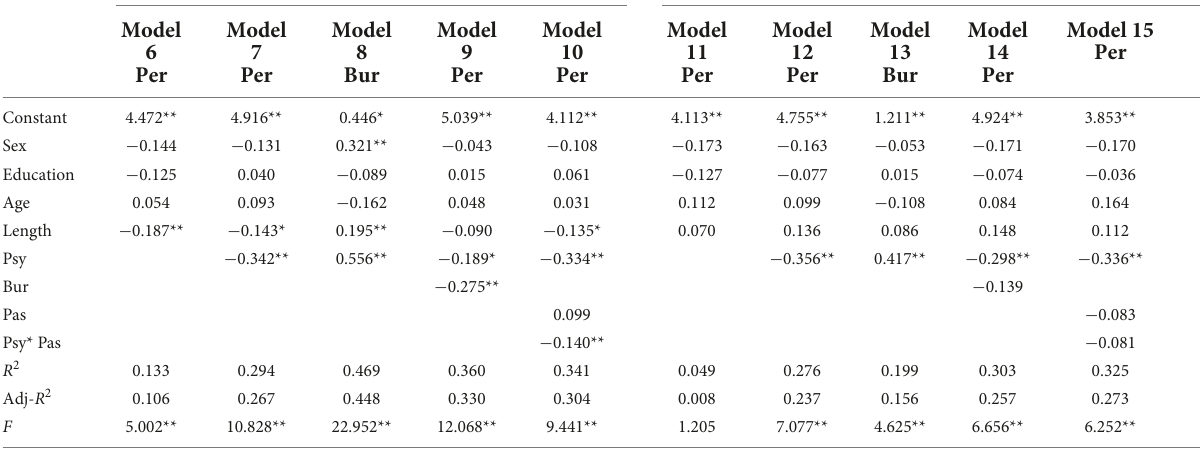
TABLE 5 Test results of the relationship between psychological contract breach and job performance of new generation of employees (grouped by the nature of enterprises).